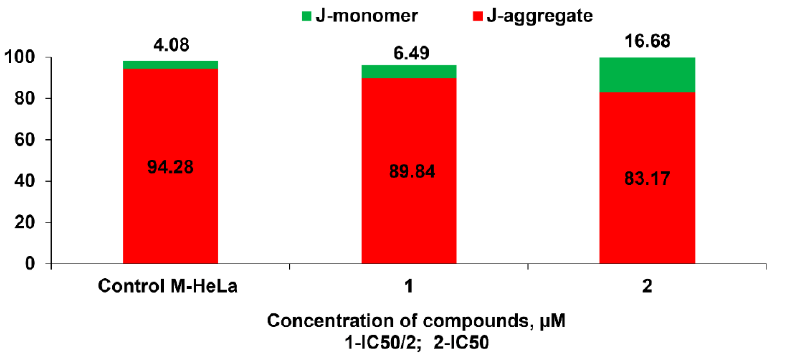
Figure 12. Quantitative determination of % M ‐ HeLa cells with red and green aggregates. 1—at concentration IC 50 /2 (6 µ M); 2—at concentration IC 50 (12 µ M).